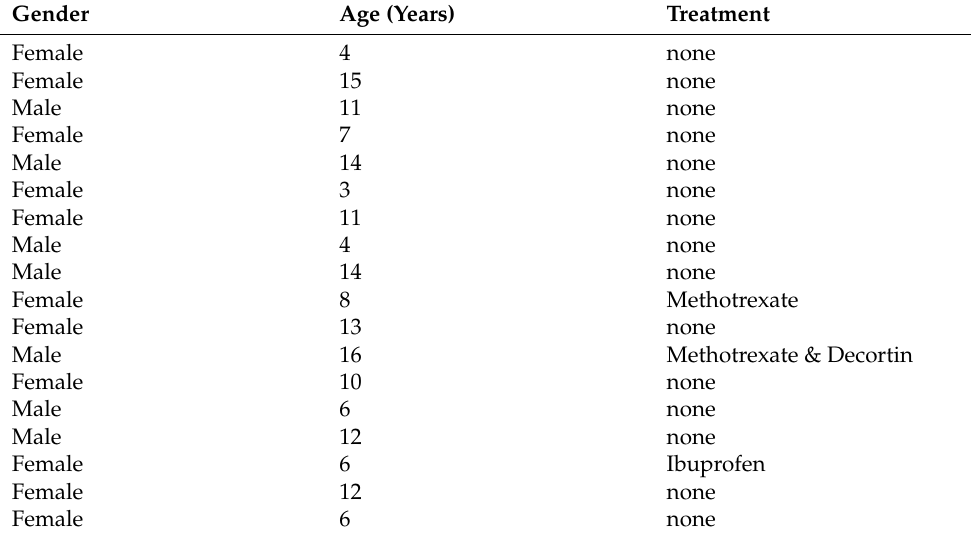
Table 1. Details of oligoarticular JIA patients with treatment